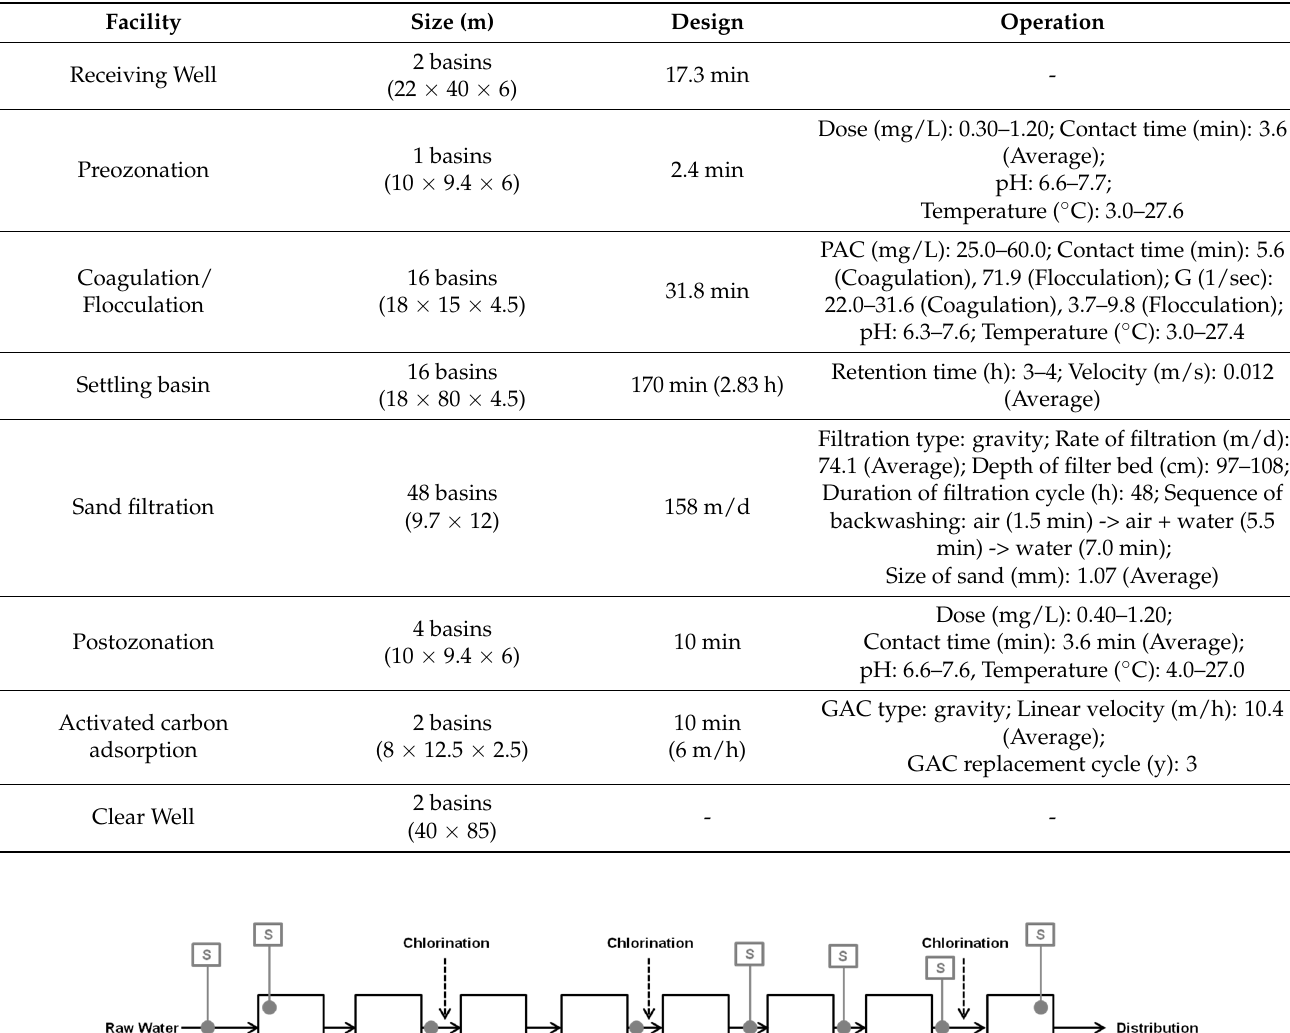
Table 1. Facility design and operation information.